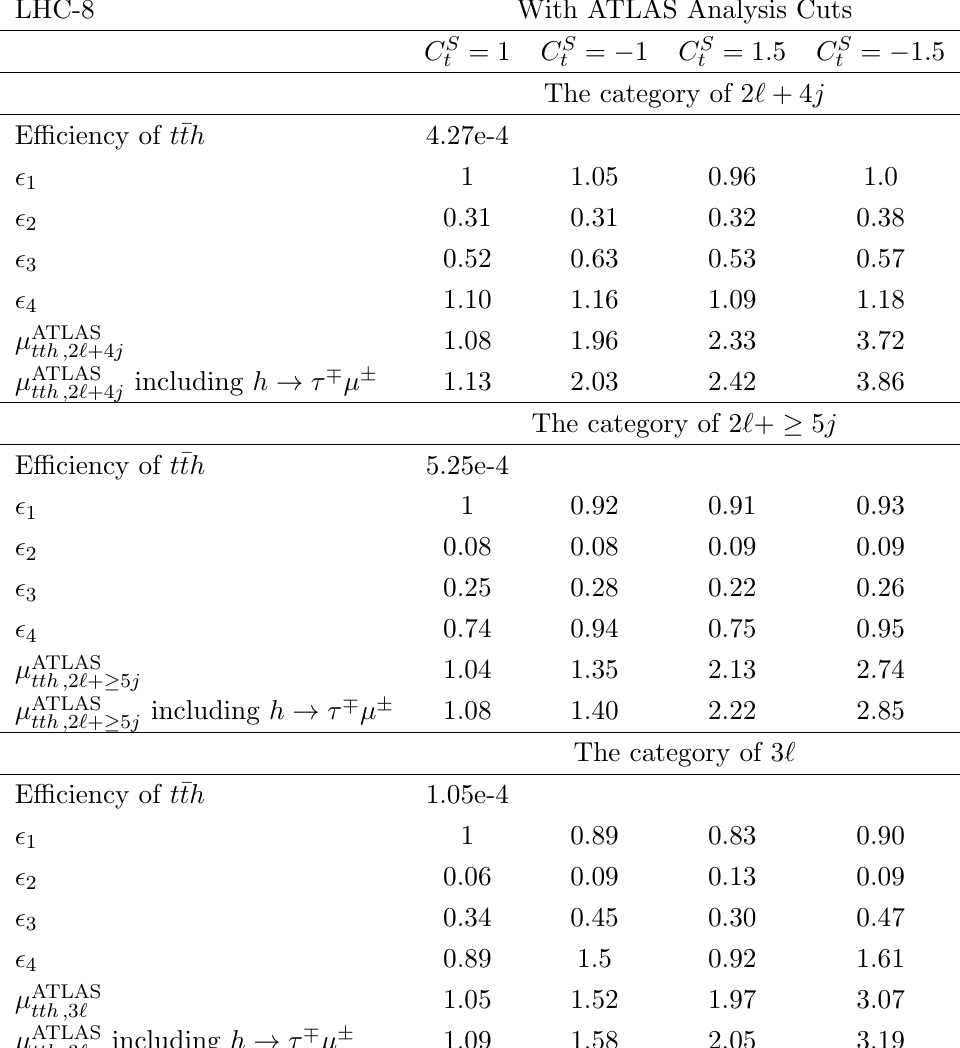
Table 6 . Category Leptons: the same as table 5 but with the ATLAS